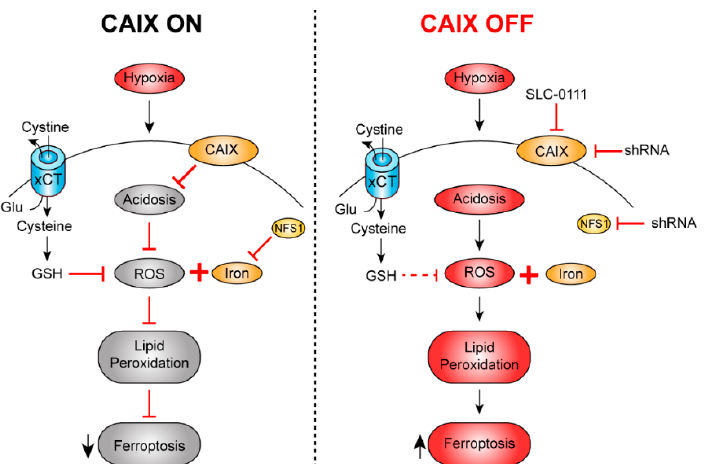
Figure 1. Hypoxia-induced CAIX activity and iron–sulfur clustering are co-vulnerabilities that can be targeted in combination to induce ferroptosis-mediated death of cancer cells. When CAIX is active (CAIX ON) in the presence of NFS1, intracellular pH and reactive oxygen species (ROS) are effectively regulated, resulting in low levels of lipid peroxidation and inhibition of ferroptosis. Combinatorial inhibition of CAIX activity (CAIX OFF) and NFS1 expression results in intracellular acidosis and deregulation of iron-sulfur clustering which leads to increased ROS, induction of lipid peroxidation and promotion of ferroptosis. Treatment strategies designed to inhibit CAIX and induce ferroptosis have the potential to overcome therapeutic resistance in hypoxic tumors. GSH, glutathione; Glu, glutamate.